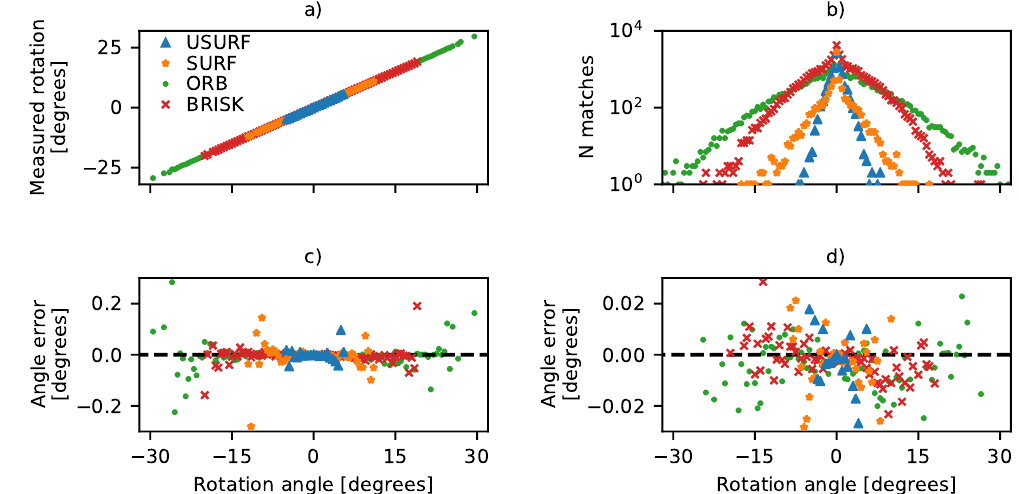
Figure 5. Accuracy of rotation measurements made using the USURF, SURF, ORB, and BRISK feature tracking methods, using experimentally rotated speckle patterns. ( a ) Measured rotation versus applied rotation. ( b ) The number of matched features after application of distance threshold, described in Section 4.2 and Table 2. Missing data points are where too few features were matched to successfully calculate the transform. The remaining plots ( c , d ) show the measurement error, with ( d ) having the vertical scale changed to show achievable